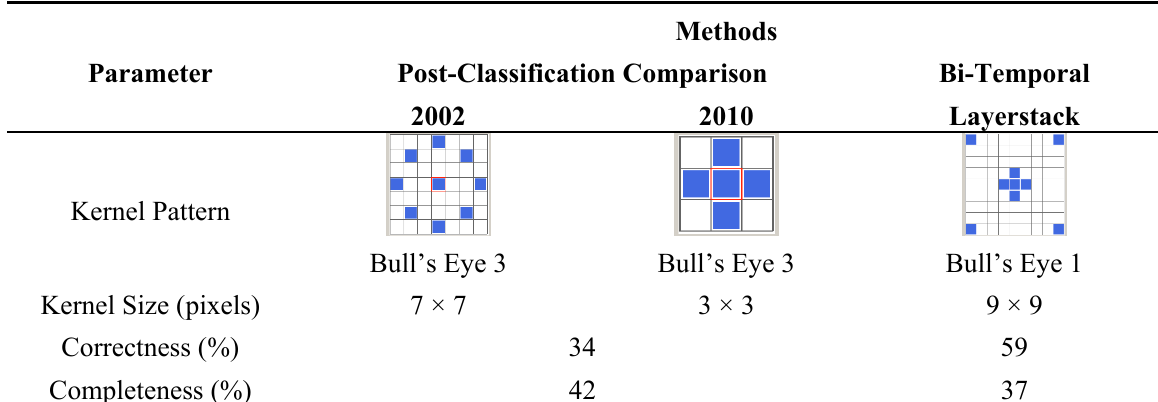
Table 4. Feature Analyst Approach